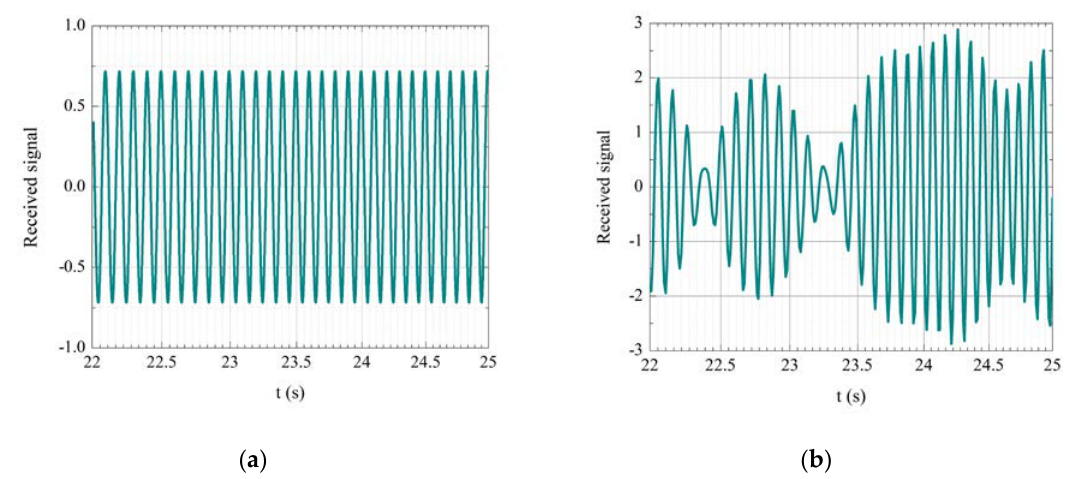
Figure 5. The multipath effect of the signal and the combined effect of multipath and Doppler of the signal. ( a ) No Doppler frequency shift; ( b ) With Doppler frequency shift.